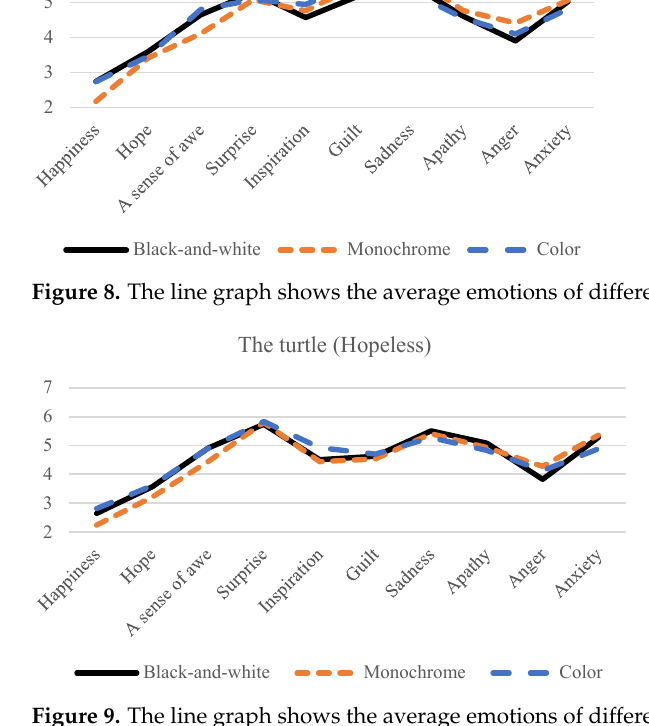
Figure 10. The line graph shows the average emotions of different colors in #5 image. 5.2. Cognitions The analysis was based on the results from Tables 1 and 2 of cognitions in the ques ‐ tionnaire (Q11–Q20). The following are the experimental results from all five digital paint ‐ ings used to test hypothesis H2. #1 The wooden cage (Comfort zone) Confrontational and challenging social norms (Q16)—The monochrome image was significantly different from both the black ‐ and ‐ white and color images. This cognitive level was highest with the monochrome image.